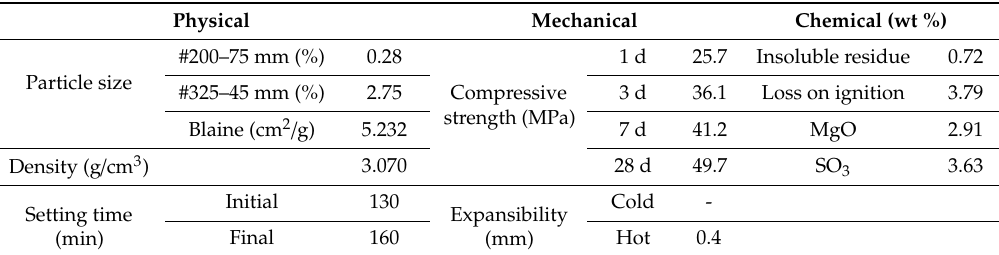
Table 1. Properties of Portland cement used in this study.